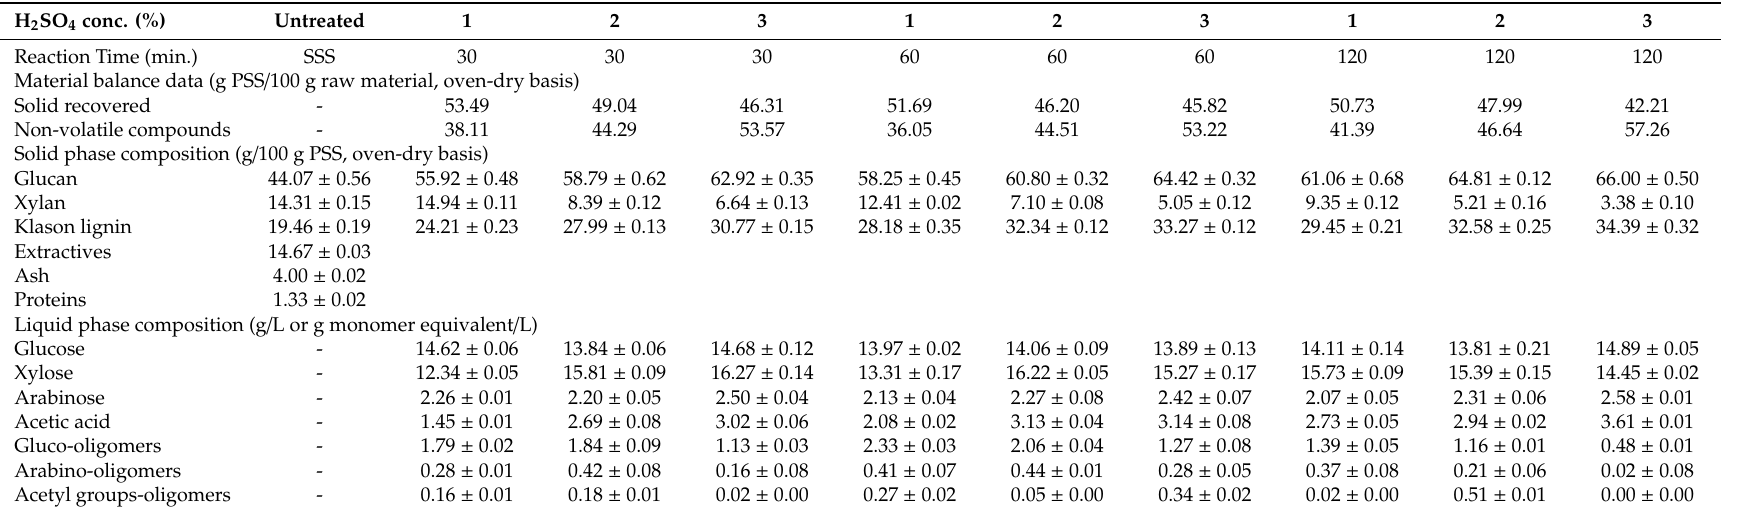
Table 1. Operational conditions employed in SSS dilute acid pretreatment at temperature of 121 ◦ C and experimental results concerning material balances and composition of solid and liquid